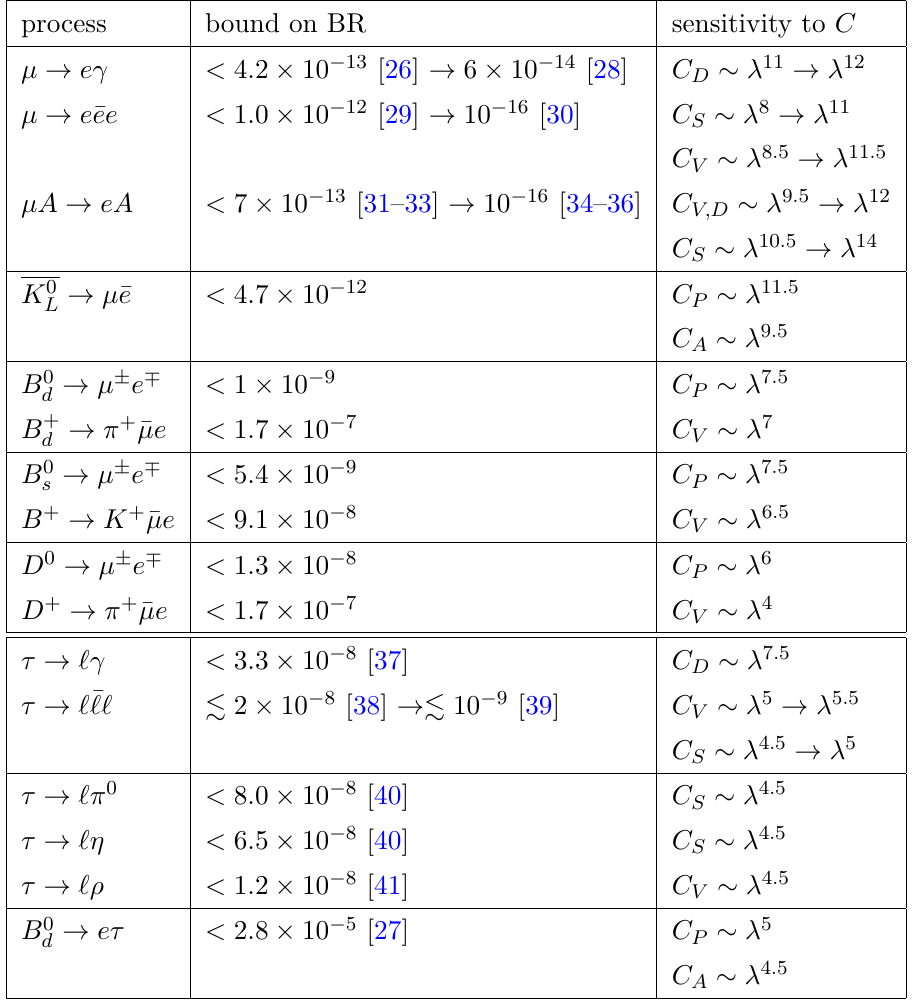
Table 3 . Some current and upcoming experimental bounds on LFV Branching Ratios ( τ ↔ µ results are similar to τ ↔ e ). The third column gives the order of magnitude of dimension six operator coefficients that reproduce the experimental numbers, in powers of λ ’ 1 / 5 . The listed coefficients C contribute to the process at tree level, are labelled by the operator’s Lorentz Lor structure, and are normalised to a scale Λ = v = 174 GeV in eq. (2.1). The meson decay bounds are from [27], the coefficient sensitivities from [10, 42,